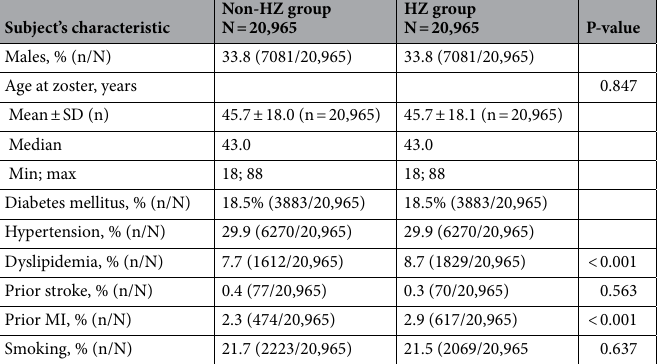
Table 1. Clinical and demographic characteristics of study population grouped according to Zoster exposure status.